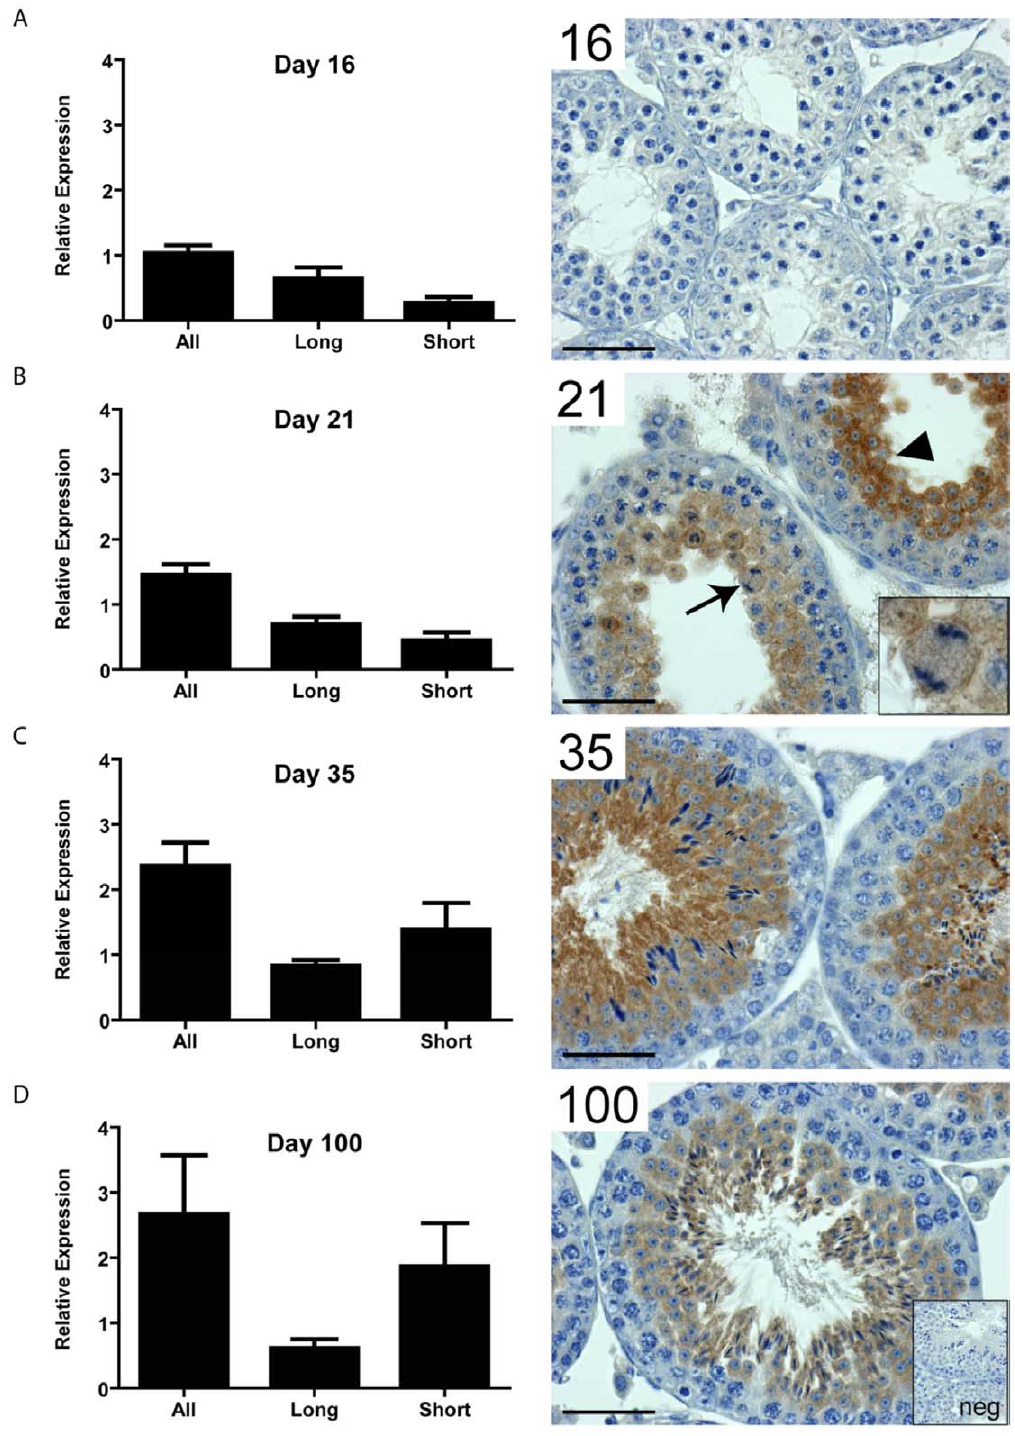
Figure 7. LKB1 splice variant relative gene expression and testicular localisation. A ) At day 16, prior to meiosis, testicular LKB1 is expressed at relatively low levels, with LKB1 protein below the detectable limits of colourimetric immunohistochemistry. B ) At day 21 total LKB1 expression has increased, predominantly through increased expression of LKB1 S . LKB1 protein can be detected in meiotic spermatocytes (inset and arrow), and post- meiotic spermatids (arrowhead). At day 35 ( C ) and day 100 ( D ), the predominant transcript is LKB1 S with LKB1 protein localised to the cytoplasm of elongated spermatids in addition to round spermatids and spermatocytes, (scale bar =50 m m). The insert labelled ‘neg’ shows a negative control in which no primary antibody was incubated with the tissue.